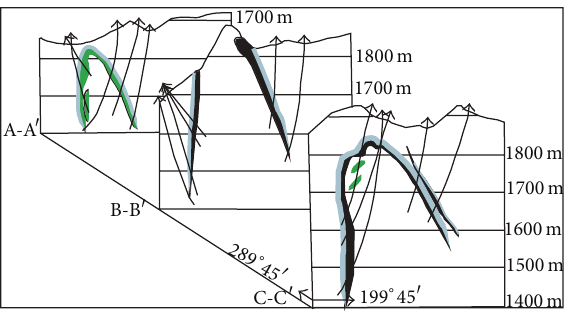
Figure 4: Cross-sections of ore body and siliceous rock in the Bafangshan-Erlihe Cu-Pb-Zn ore deposit. For location see Figure 3